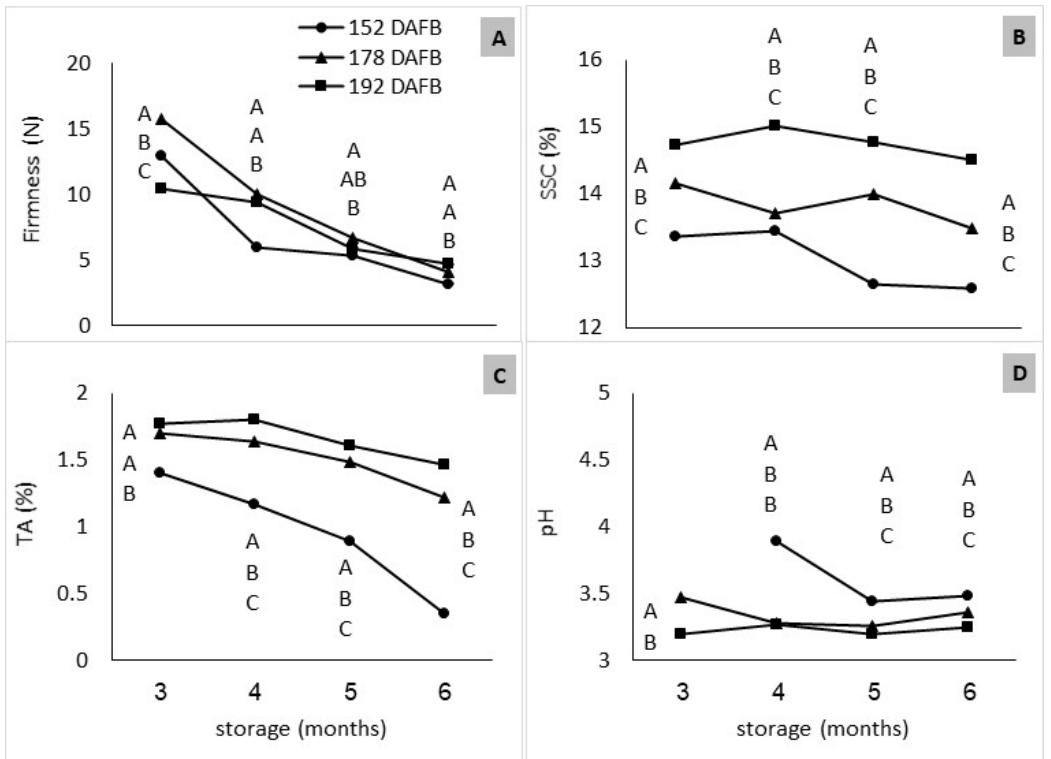
Figure 2. Effect of kiwifruit harvest time on changes in firmness ( A ), SSC ( B ), TA ( C ) and pH ( D ) during RA storage. The letters A–C represent significant differences at each month (Duncan p < 0.05).